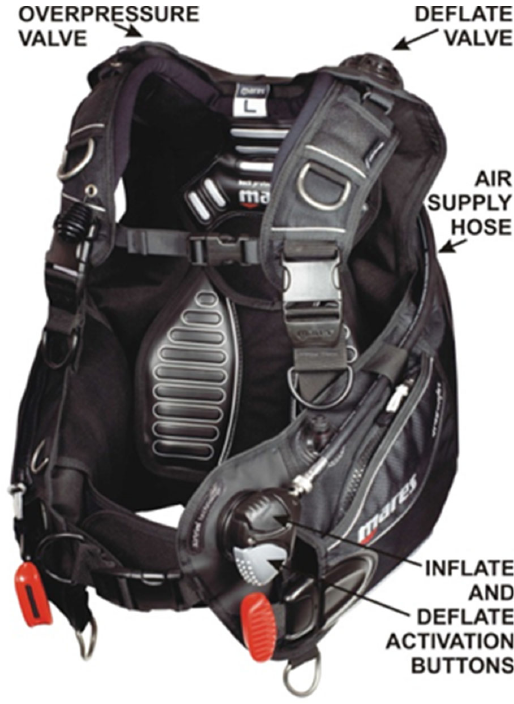
Figure 1. Modern type of the buoyancy control device or BCD.